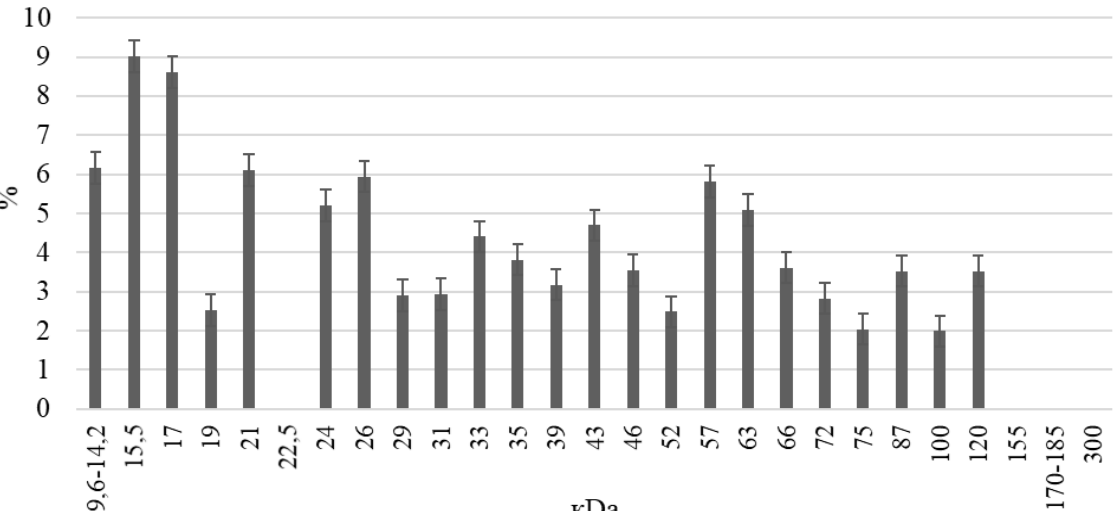
Fig. 5. Structural proteins of the basolateral membrane of the jejunum enterocytes of the three-month-old cattle fetus (M ± m; %; n = 6)